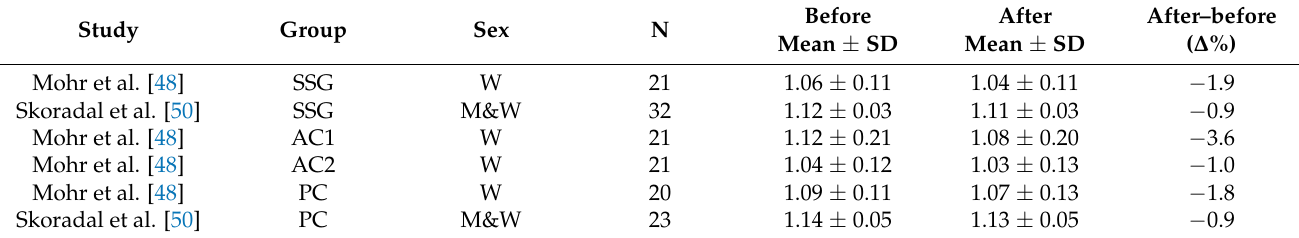
Table 8. Summary of the included studies and results of pelvis BMD before and after the